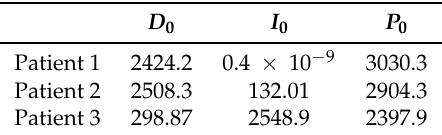
Table 3. Initial conditions for different patient